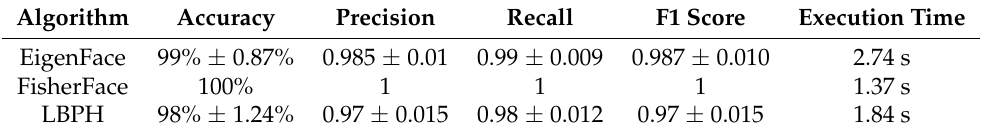
Table 2. Accuracy, precision, recall, F1 score, and execution time on AT&T dataset.